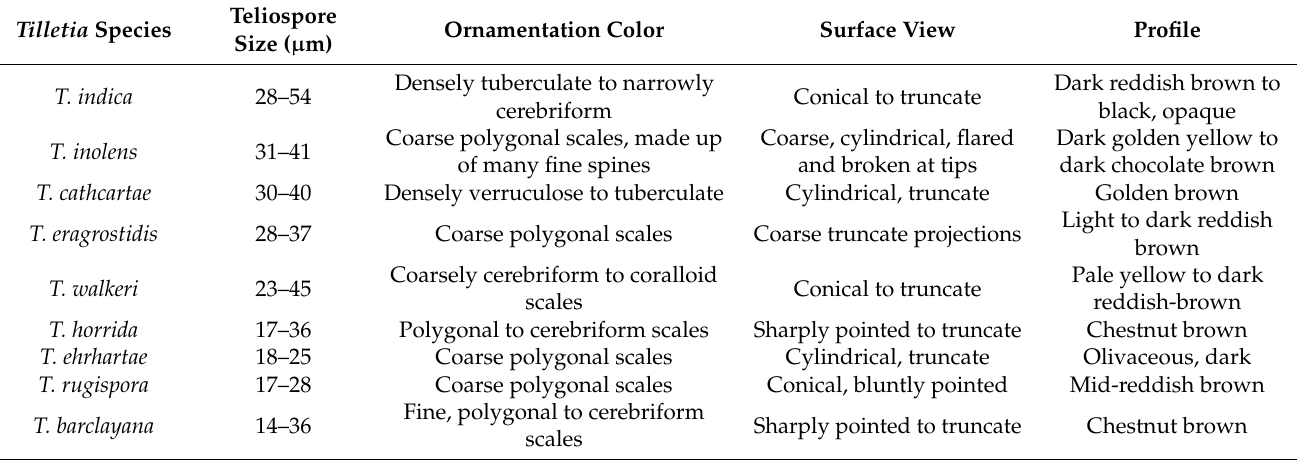
Table 1. Morphologically similar teliospore details of Tilletia